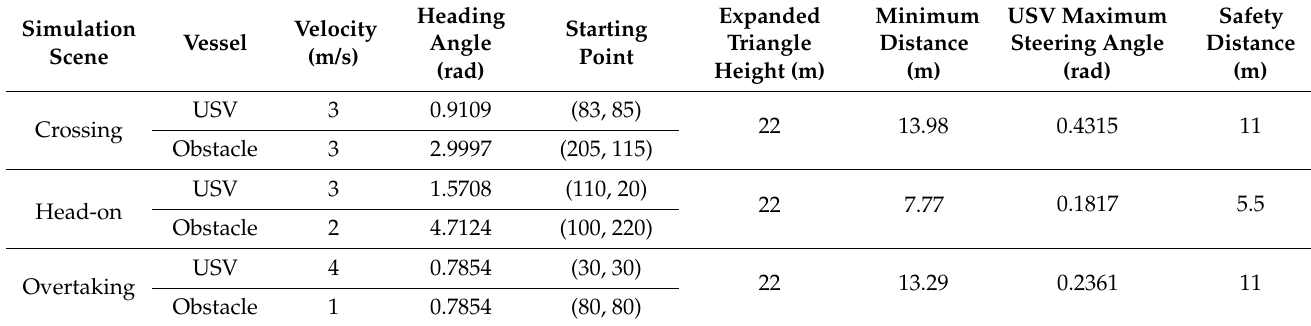
Table 3. Simulation data of improved VO for a single ship.